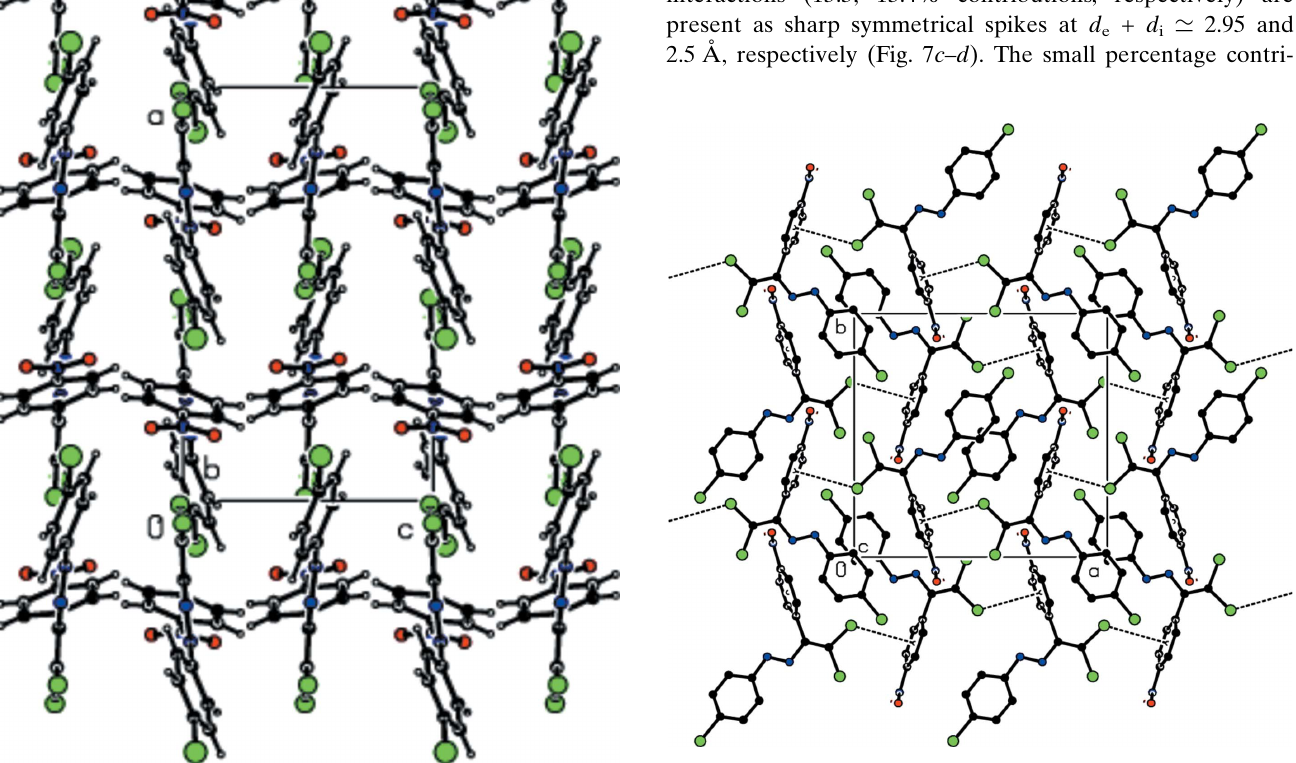
’ 2.8 A˚ (Fig. 6 c ). + d e i + e ’ 2.95 and + d e i